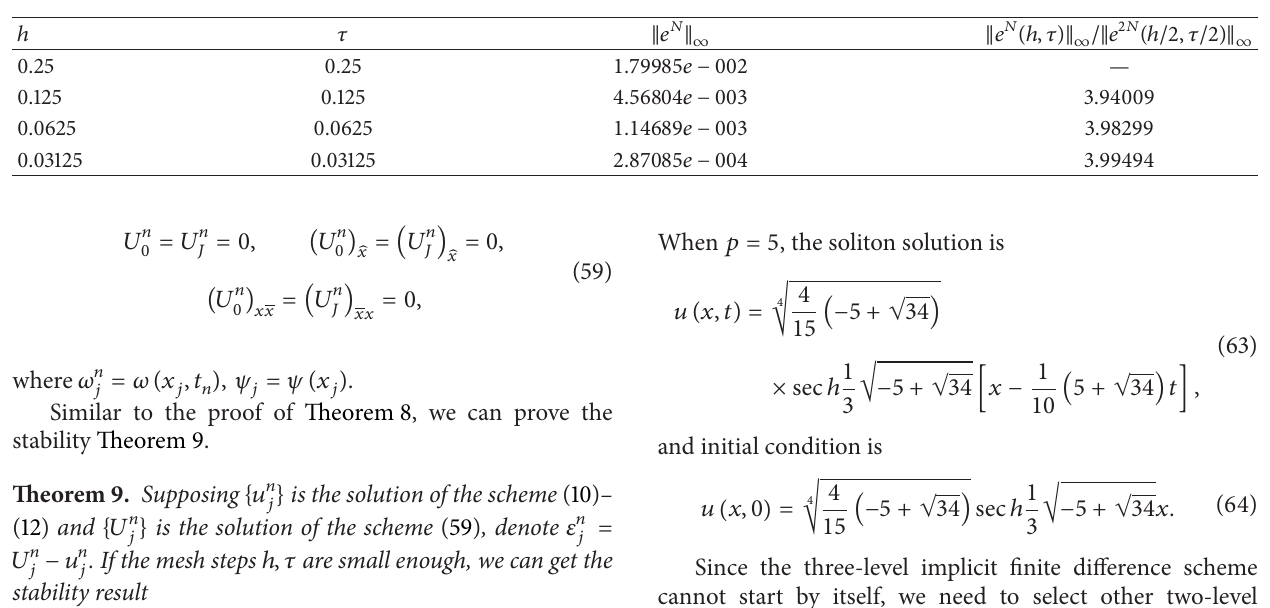
Table 2: The errors estimated in the sense of 𝐿 ∞ for 𝑝 = 5 at 𝑇 = 40